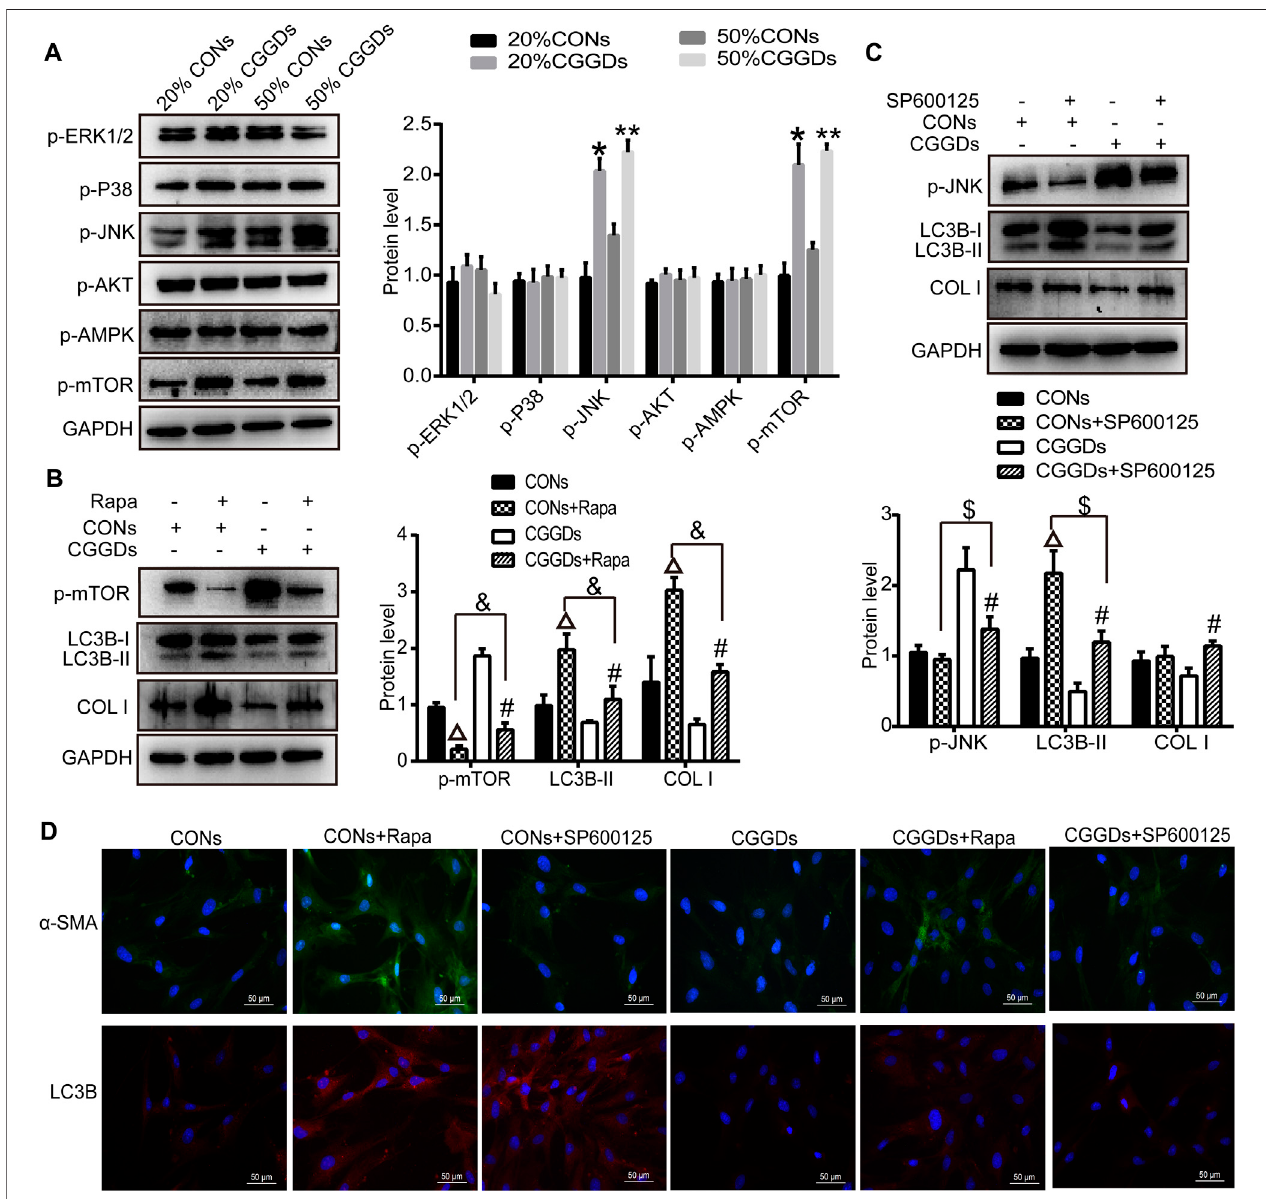
FIGURE 6 | Effect of CGGDs on PSC autophagy and activation through the JNK/mTOR pathway. (A) Western blot analysis of p -ERK1/2, p -P38, p -JNK, p -AKT, p -AMPK, and p -mTOR after PSCs were treated with 20% or 50% CONs or CGGDs, respectively, for 24 h. (B) Protein levels of p -mTOR, LC3B-I/II, and COL I in PSCs detected after pretreatment with rapamycin (Rapa, an mTOR inhibitor) for 1 h followed by treatment with 50% CONs or 50% CGGDs for 24 h. (C) Expression levels of p -JNK,LC3B-I/II,andCOLIinPSCsmeasuredbywesternblotaftertreatmentwithSP600125(aJNKinhibitor)for1 hand50%CONsor50%CGGDsfor24 h. (D) Immuno fl uorescencestainingusedtodetecttheexpression levelsof α -SMA(green)andLC3B(red)afterPSCswerepretreatedwithRapaorSP600125for1 hfollowed bytreatment with50%CONsor50%CGGDsfor24 h.ThenucleiwerestainedwithDAPI(blue)(originalmagni fi cation: × 200).Thedataareexpressedasthemean ± SD of three independent experiments. * p < 0.05 vs. the 20% CONs group, ** p < 0.05 vs. the 50% CONs group, △ p < 0.05 vs. the CONs group, # p < 0.05 vs. the CGGDs group, p < 0.05 vs. the CONs + Rapa group, and $ p < 0.05 vs. the CONs + SP600125 group.